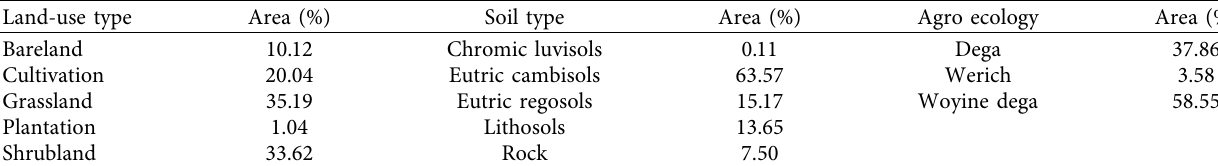
Figure 2: Long-term (1994–2021) monthly rainfall (RF), maximum temperature ( T max ), and minimum temperature ( T min ) in the study area. Table 1: Existing land use, soil, and climatic conditions of the study